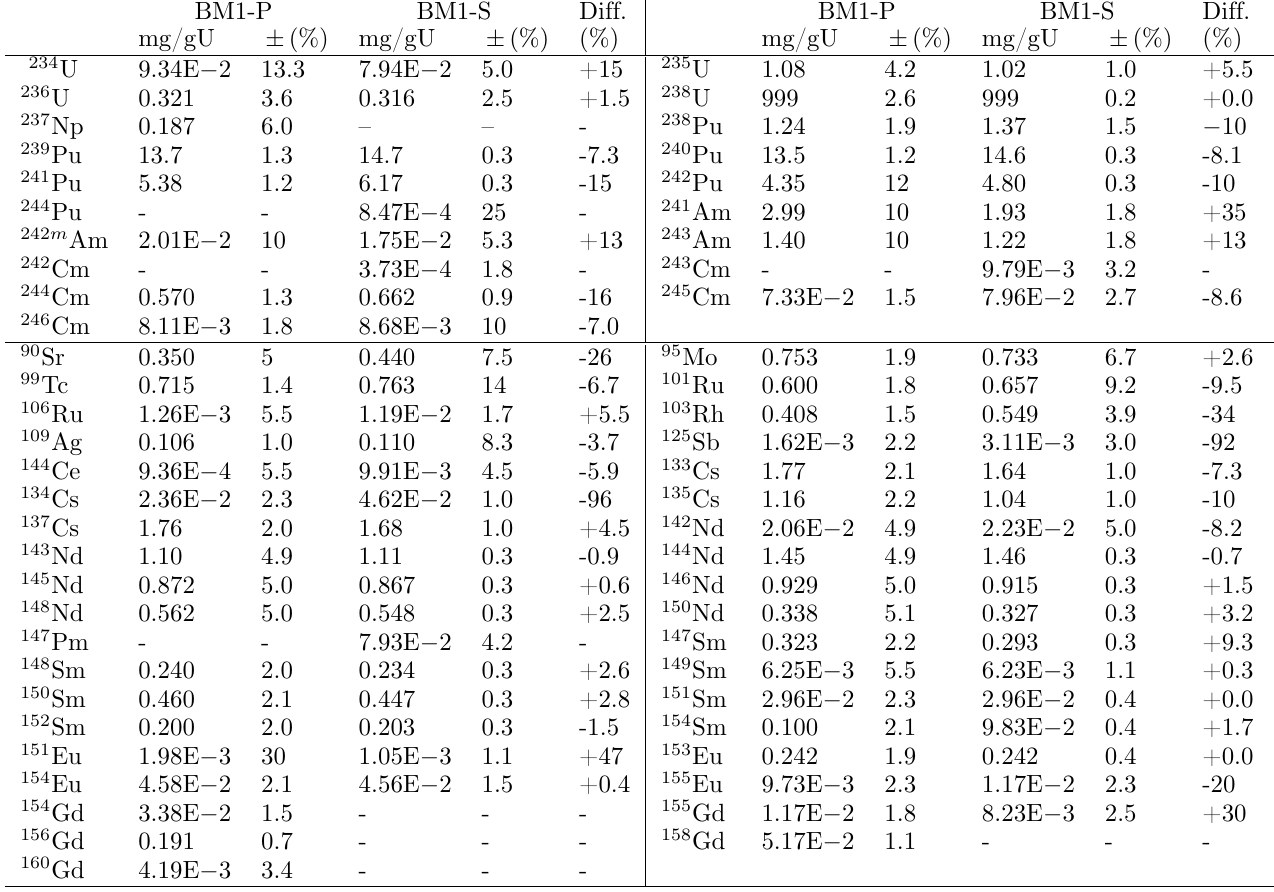
Table B.1. Measured concentrations for the BM1-P (from PSI) and BM1-S (from SCK-CEN) samples, with their